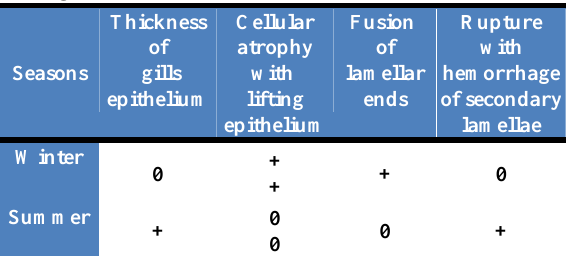
Table, 1: Explained alterations of the Carp’s gill during winter and